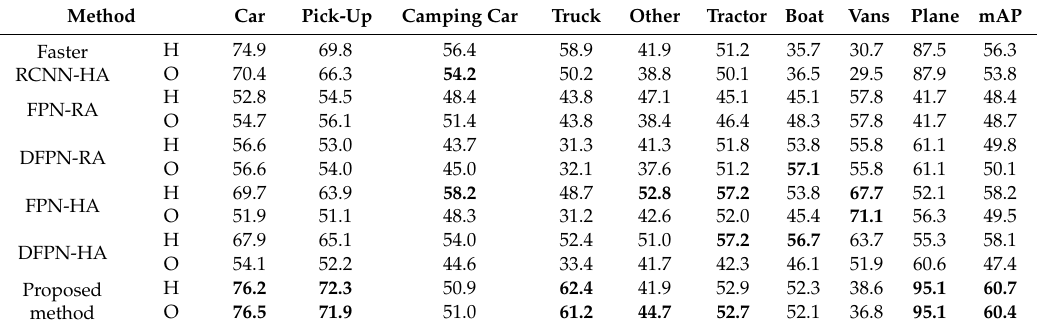
Table 3. Horizontal and oriented detection results of comparison